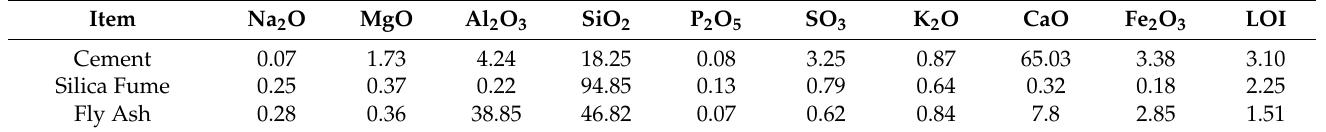
Table 1. Chemical composition of the used cement, silica fume, and fly ash (%).